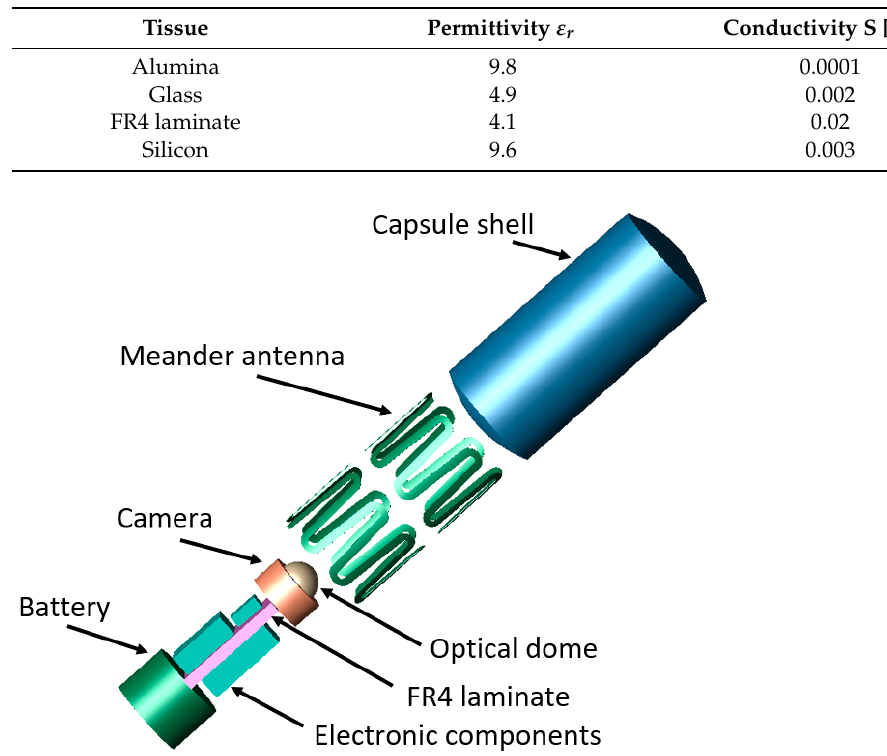
Table 1. Electrical properties capsule model materials.